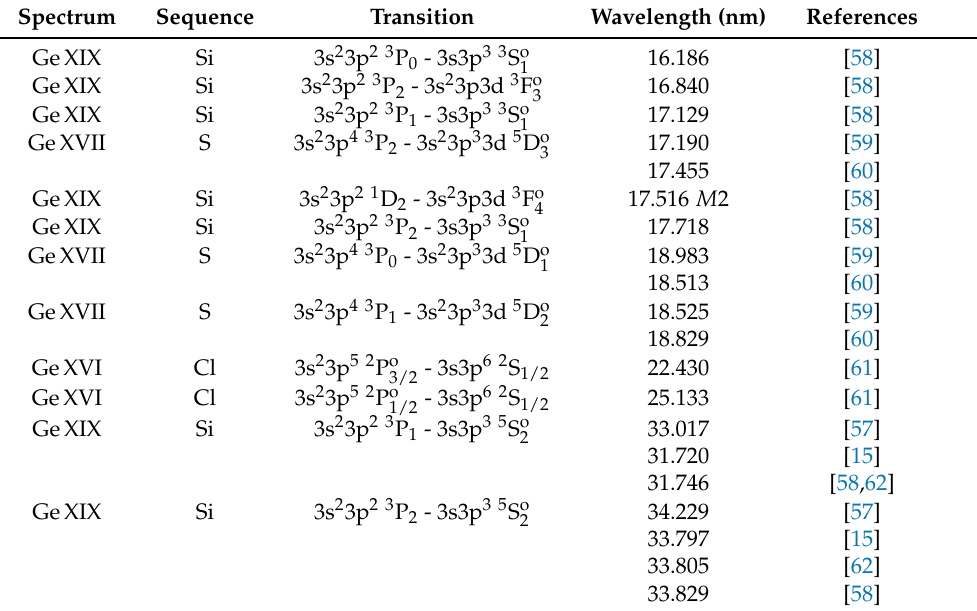
Table 2. Sample transitions in Si- through Cl-like ions of Ge predicted by theory.